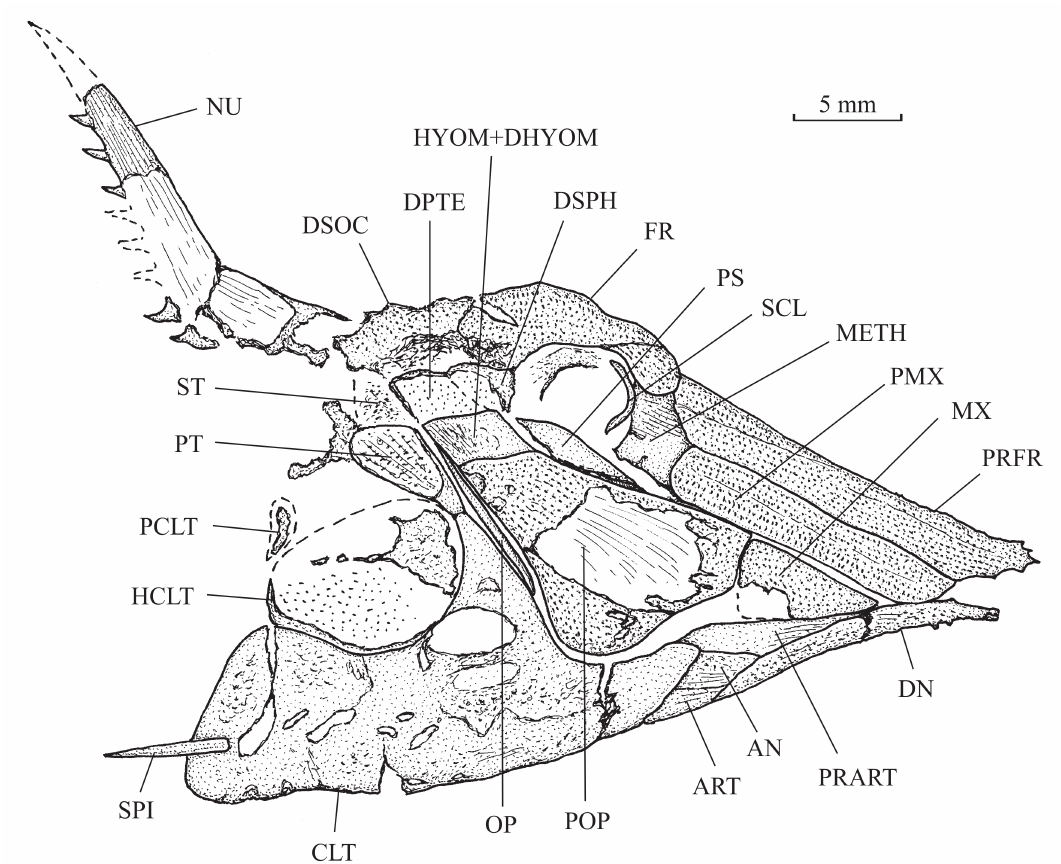
Fig. 5. Joinvillichthys lindstroemi (Davis, 1890). Skull and pectoral girdle of holotype, NRM PZ P.